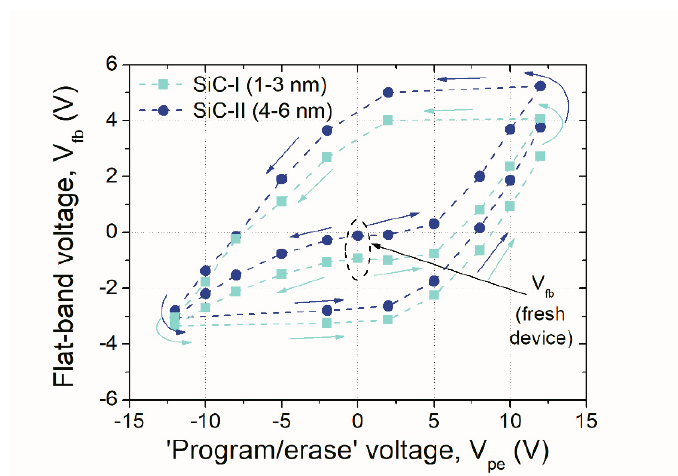
Figure 7. Memory window (expressed as V fb change) of NC-MIS devices with both types of SiC-NCs examined in this study; V p/e = 0–±12 V, and stress time = 1 s were used.